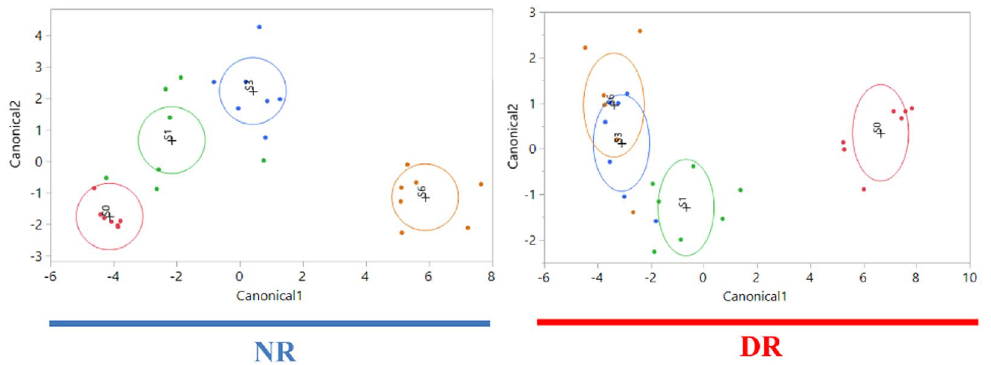
Figure 8. Discriminant analyses of fecal sample microbiome for each treatment group (NR and DR) by week. Differences in the fecal microbial profiles for each sampling week (S0 = red dots, S1 = green dots, S3 = blue dots, S6 = orange dots) are illustrated by Canonicals 1, and 2. An ellipse indicates the 95% confidence region to contain the true mean of the group, and a plus symbol indicates the center (centroid) of each